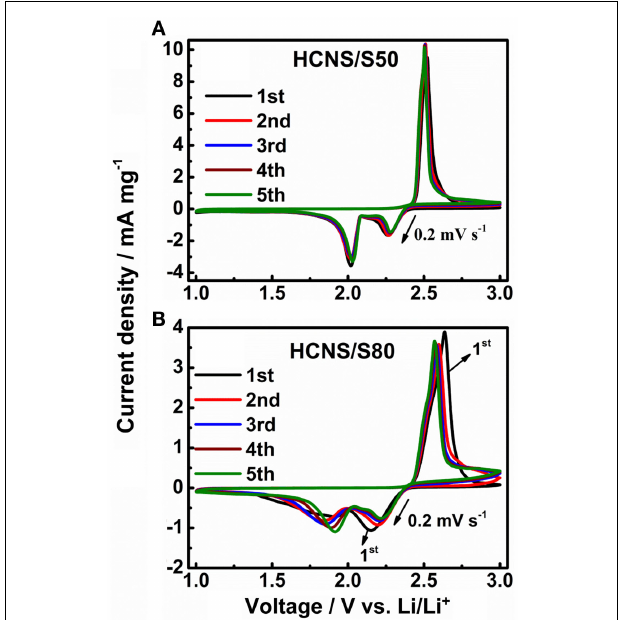
FIGURE 4 | Cyclic voltammograms (CV) of HCNS/S composite cathodes at 0.2mVs (cid:0) 1 . (A) HCNS/S50 composite, (B) HCNS/S80